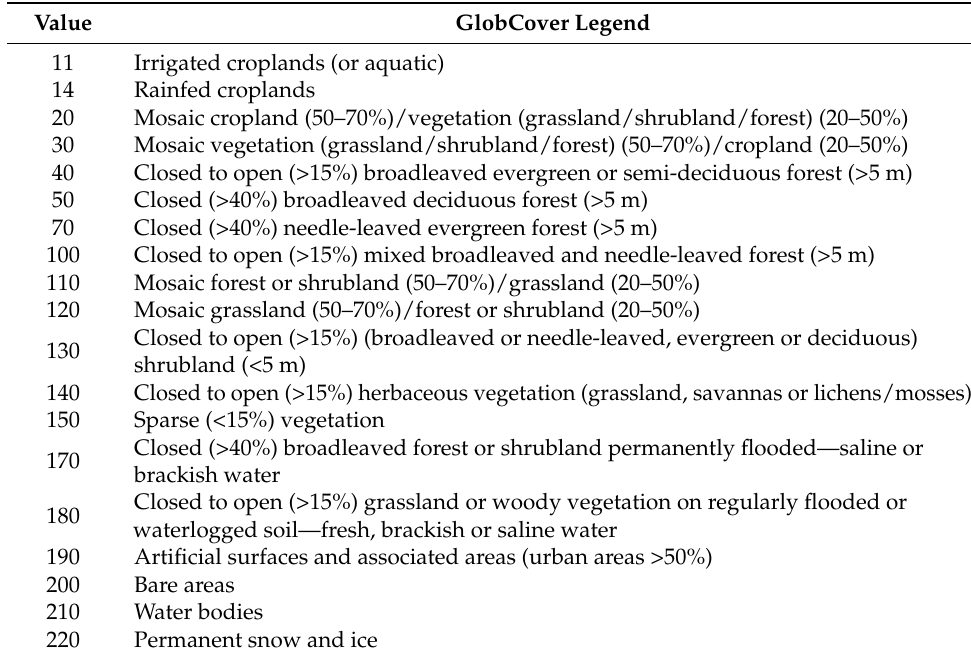
Table 1. GlobCover land use land